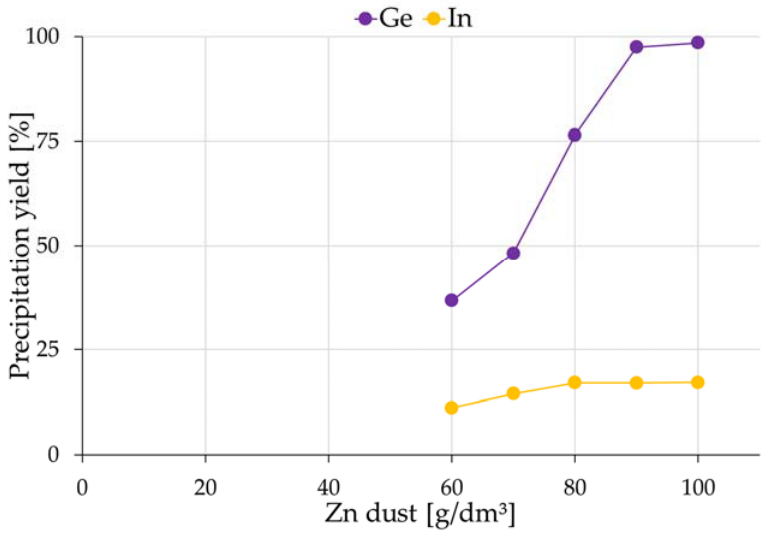
Figure 5. Influence of Zn dust amount on precipitation yields of Ge and In (75 °C, 2 h, detinned solution, final pH 1.0).